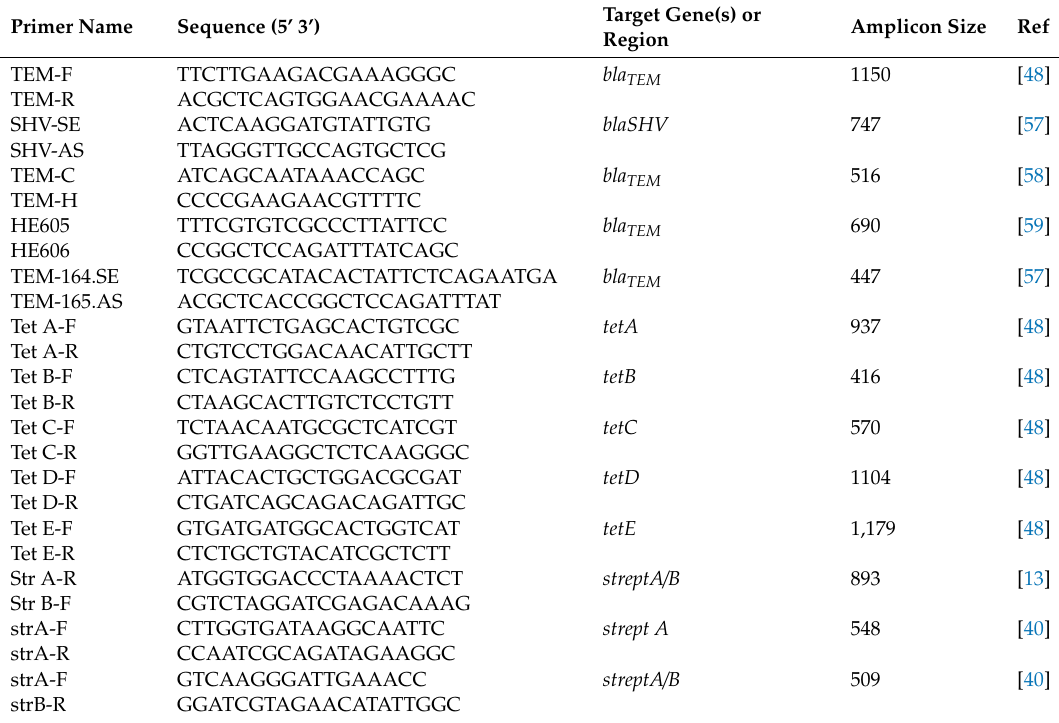
Table A1. Primers used in